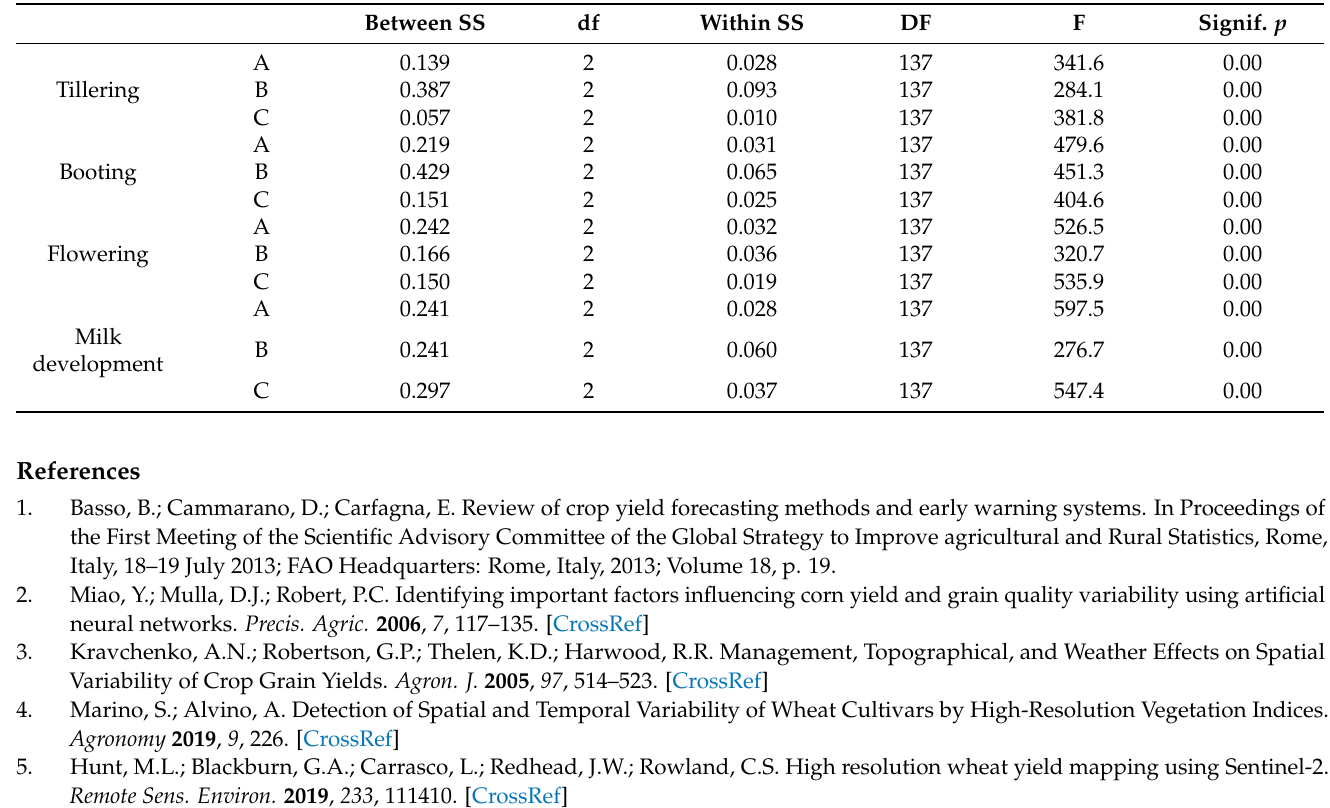
Figure A2. Box plot of the NDVI data variability in each area (A, B, C) at different growth stages (1—seedling; 2—tillering, 4—booting, 6—flowering, and 7—milk development). Table A1. Analysis of NDVI variance of clusters identified by k-means cluster method at tillering, booting, flowering, and milk development stages related to Figure 6 data.